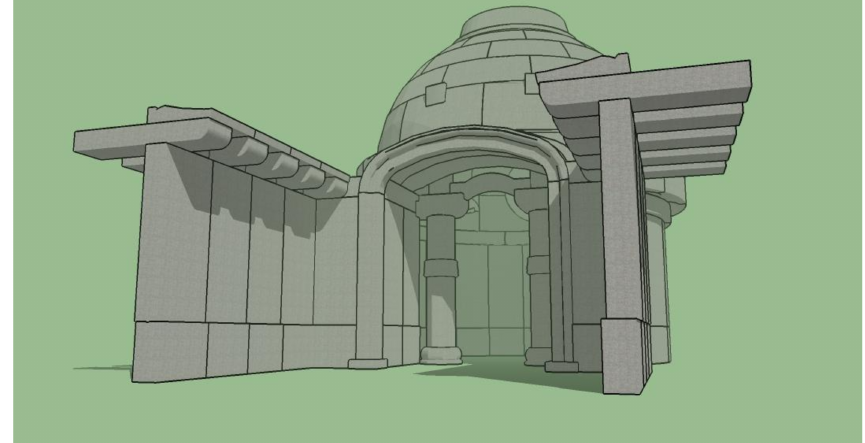
Figure 22. Model for the first structural study, assuming the absence of ‘forearms’.